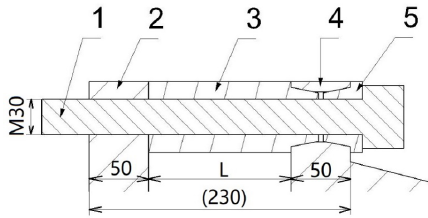
Figure 2. Connections of the MR elements pair. 1 – Explosive bolt, 2 – Rocket flange, 3 – MR element, 4 – Satellite flange, 5 – MR